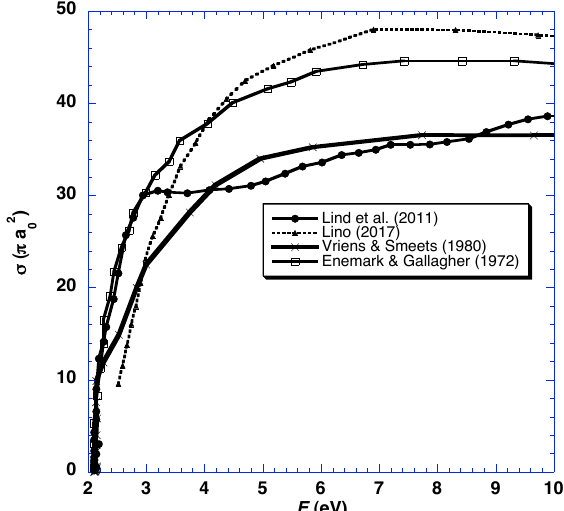
Figure 2. Excitation cross-sections σ lu ( π a 2 energies E (eV) up to 5 eV.